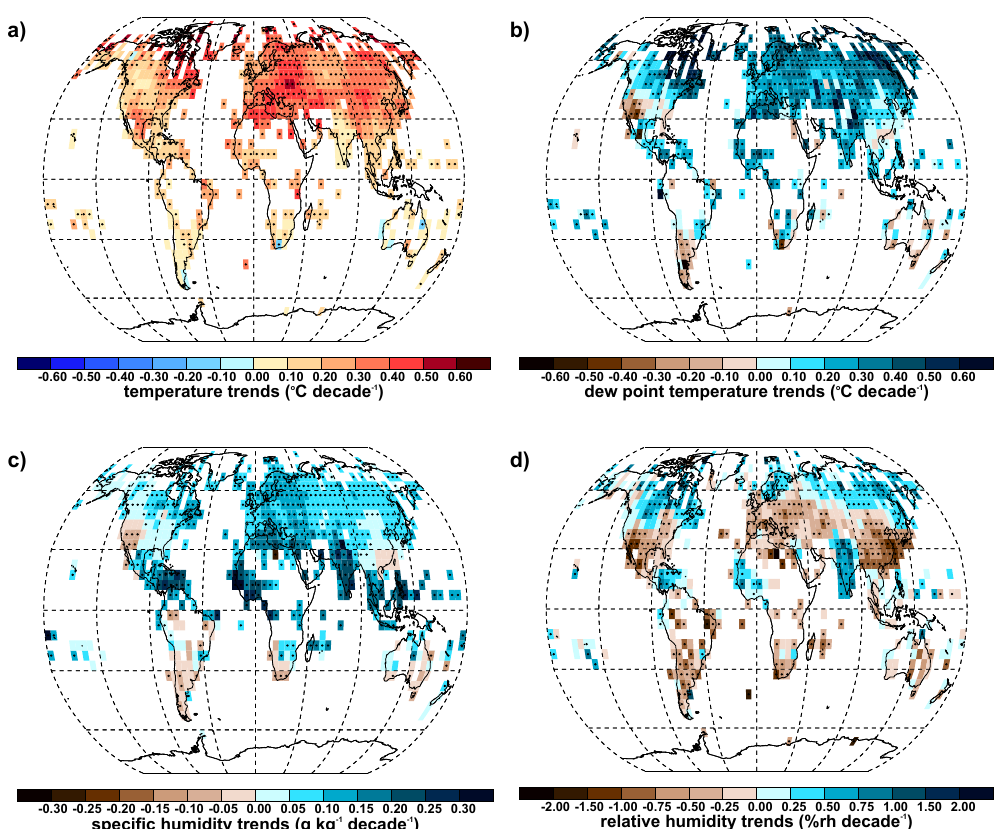
Figure 11. Decadal trends from 1973–2013 for monthly mean climate anomalies relative to 1976–2005. Trends are fitted using the median of pairwise slopes. Black dots show trends that are considered to be significantly different from a zero trend – where the 5th and 95th percentiles of the pairwise slopes are in the same direction. (a) Temperature, (b) dew point temperature, (c) specific humidity and (d) relative humidity. See Fig. SM6 for other